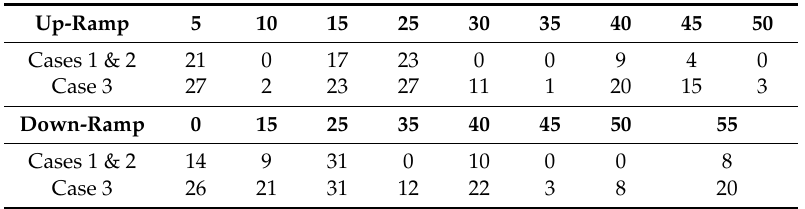
Table 7. System RC requirements for ED.